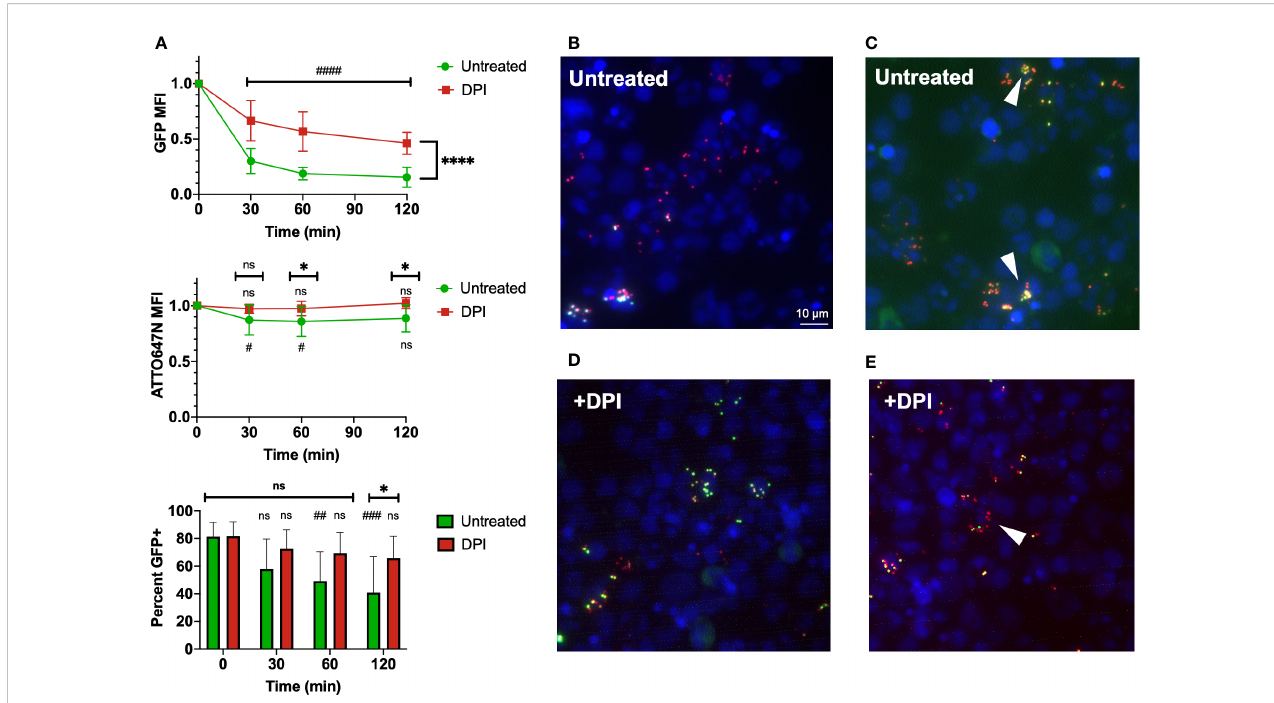
FIGURE 7 Use of bi- fl uorescent S. aureus to model infection in human neutrophils. (A) Human leukocytes inoculated with bi- fl uorescent S. aureus maintain the ATTO647N fl uorescent signal while quenching the GFP fl uorescent intensity over time based on intensity and percent GFP + cells, statistical differences between groups indicated with a * and differences within each group relative to the initial time point indicated with a # (n=8, performed across three independent experiments). (B) Imaging (60x) performed two hours after human cells were infected in vitro demonstrates cells with few cocci broadly kill the internalized S. aureus and fl uoresce as ATTO647N + (red). (C) Cells that have viable S. aureus internalized ATTO647N + GFP + (yellow, arrowheads) often have internalized larger clumps of S. aureus . (D) DPI treated human cells largely have viable (yellow) internalized S. aureus regardless of cocci internalized. (E) Some DPI treated cells still quench the GFP fl uorescent signal (red, arrowhead). “ ns ” (not signi fi cant) for p>0.05, * for p<0.05 and **** for